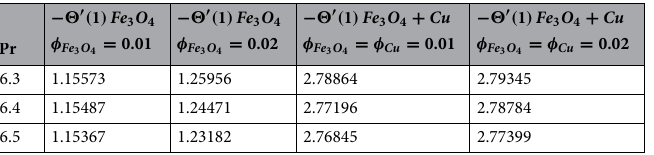
Table 7. Numerical outcomes of Nusselt number − � ′ ( 1 ) at the cone surface. When Re ω = 0.3, Re � = 0.13.